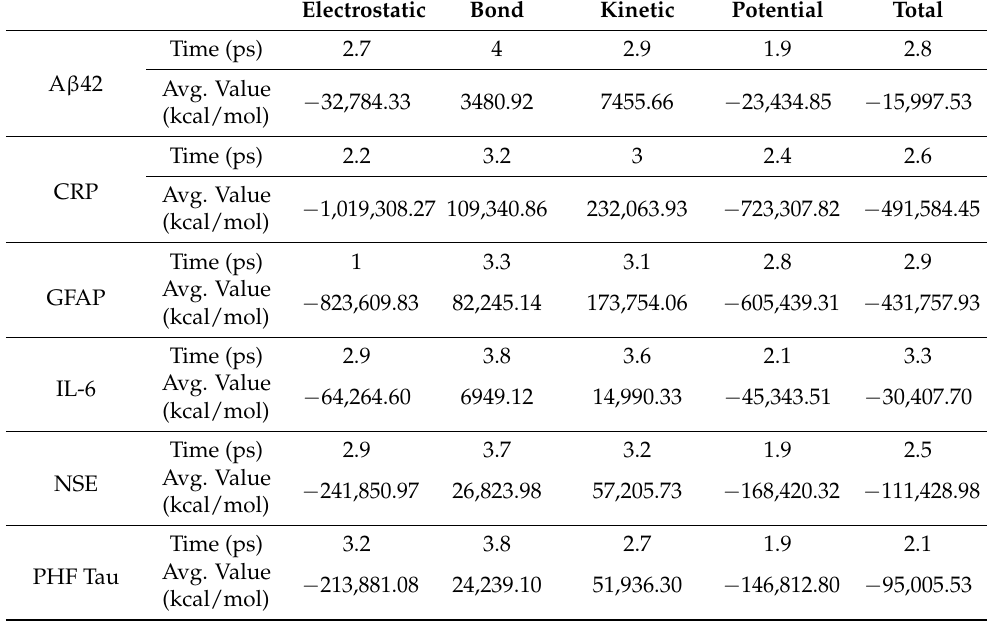
Figure 32. A plot of PHF tau’s bond, electrostatic, kinetic, total, and potential energies. It was observed from the energy plots that all energies for each biomarker was able to reach thermodynamic equilibrium. MATLAB was then used to determine the approxi- mate time to reach equilibrium for each energy and the average value of each simulation presented in Table 4. Table 4. The times at which each energy (electrostatic, bond, kinetic, potential, and total energies) reached equilibrium, and the average energy values during equilibrium for each biomarker.